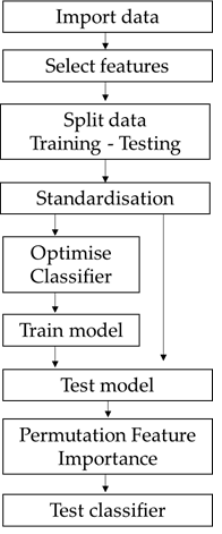
Figure 5. Permutation feature importance (PFI)